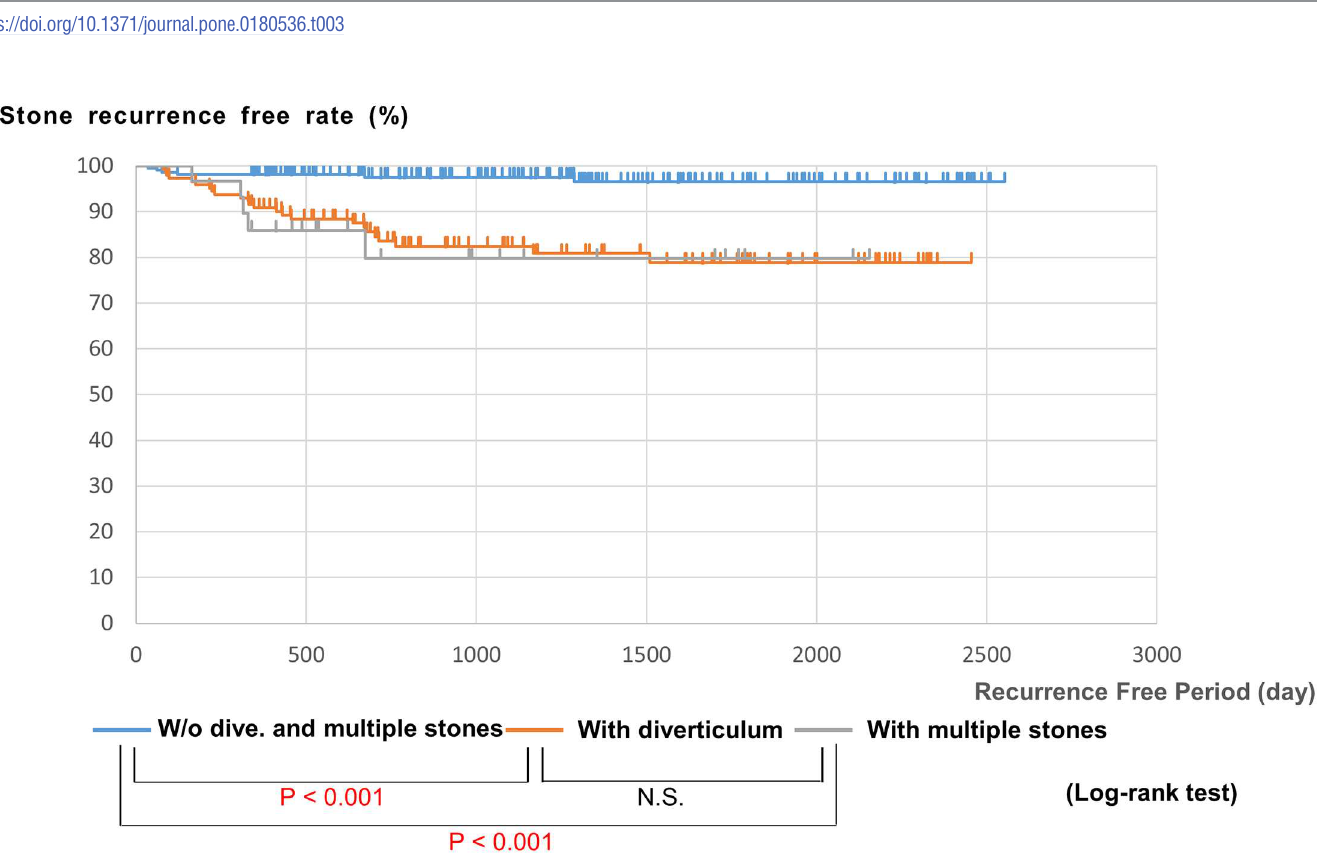
Fig 2. Recurrentfree period depend on the group with or without significant predictor (Kaplan Meier curve analysis and log-rank test). Group with PAD or multiplestones showedsignificantly short period until recurrence comparedto the group without those predictors (p < 0.001,respectively).